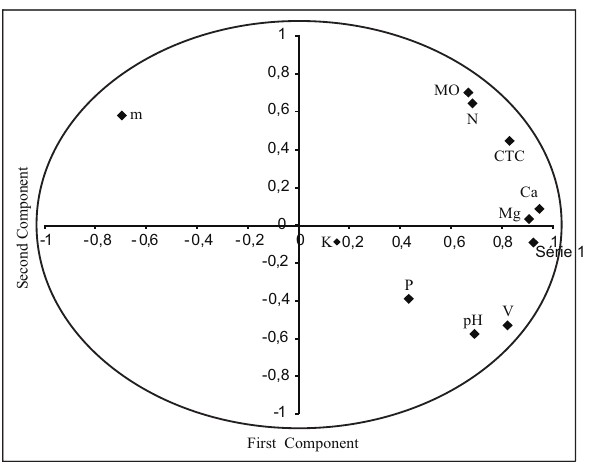
Figure 2. Eigenvectors of soil chemical variables, where: OM: organic matter; m: Al saturation; V: